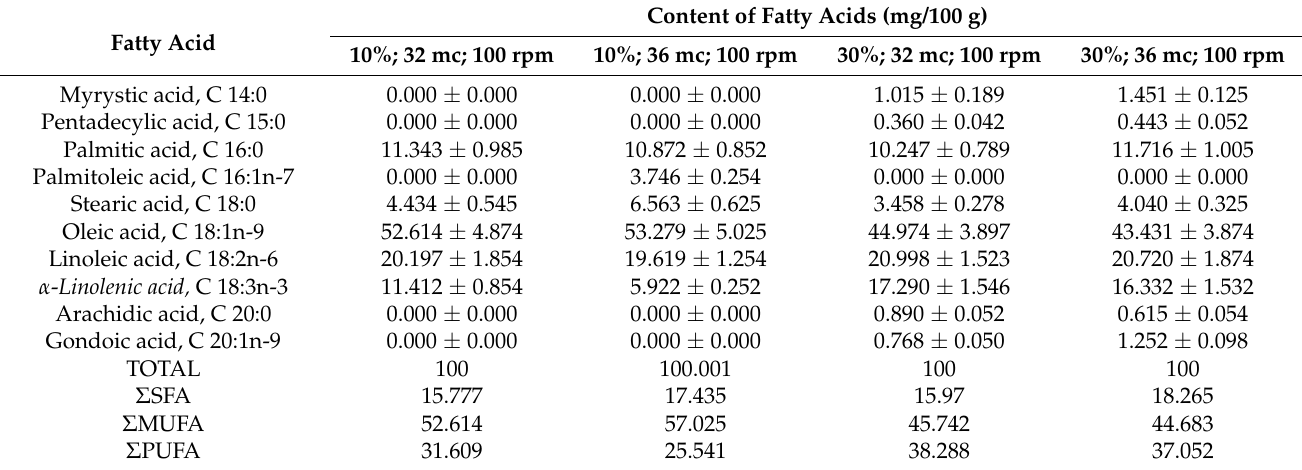
Table 9. Fatty acid profiles of snack pellets processed at a screw speed of 100